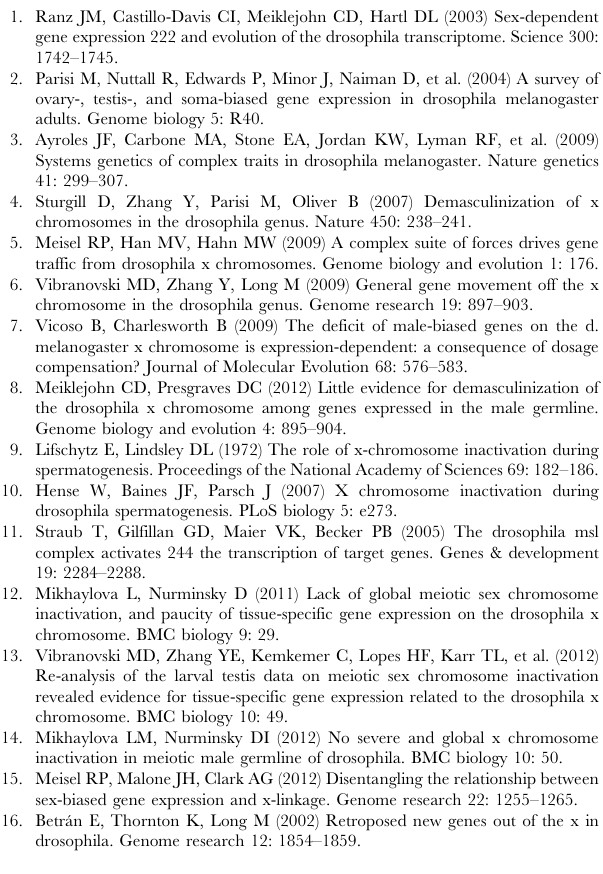
Figure S8 Relationship between sex-bias magnitudes and distance from nearest CES using gonadectomized carcass expression data from Parisi et al., 2004 Using gonadectomized carcass expression from Parisi et al., 2004 we found a significant positive correlation between sex-bias magni- tude and distance from the nearest CES when considering all X - linked MBGs (purple line, r ~ 0 : 19, p v 0 : 003 ). After partitioning X -linked MBGs into testis-biased and non-testis-biased we were unable to find any significant correlation for non-testis-biased MBGs (dashed red line, r ~ 0 : 17, p § 0 : 05 ) or testis-biased MBGs (dashed blue line, r ~ 0 : 14, p § 0 : 05 ). While we would not expect gonadectomzied carcasses to show extreme male-biased magni- tudes since the germline has been removed, it is possible that other somatic tissues, such as the male accessory gland, may have contributed to this